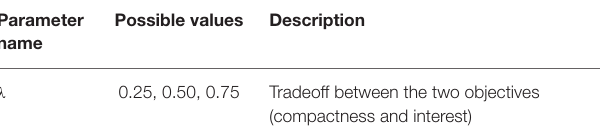
TABLE 2 | Weighted sum